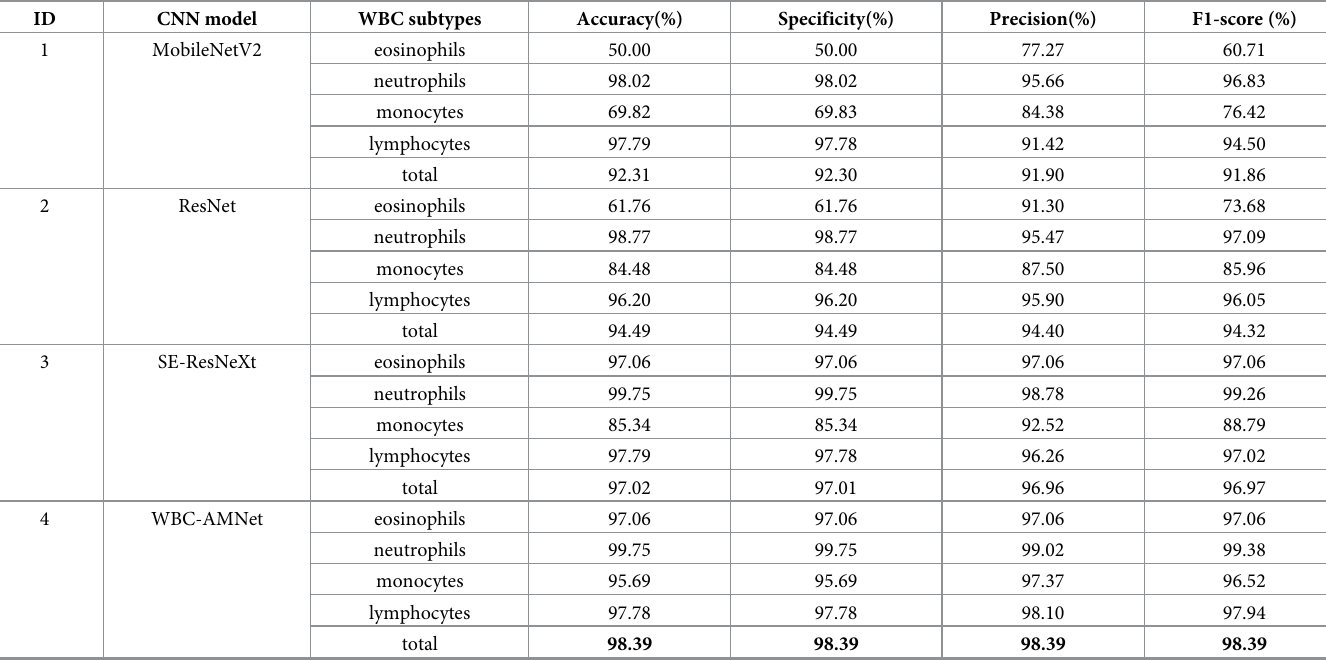
Table 9. Quad-classification results of images from WBCs dataset.